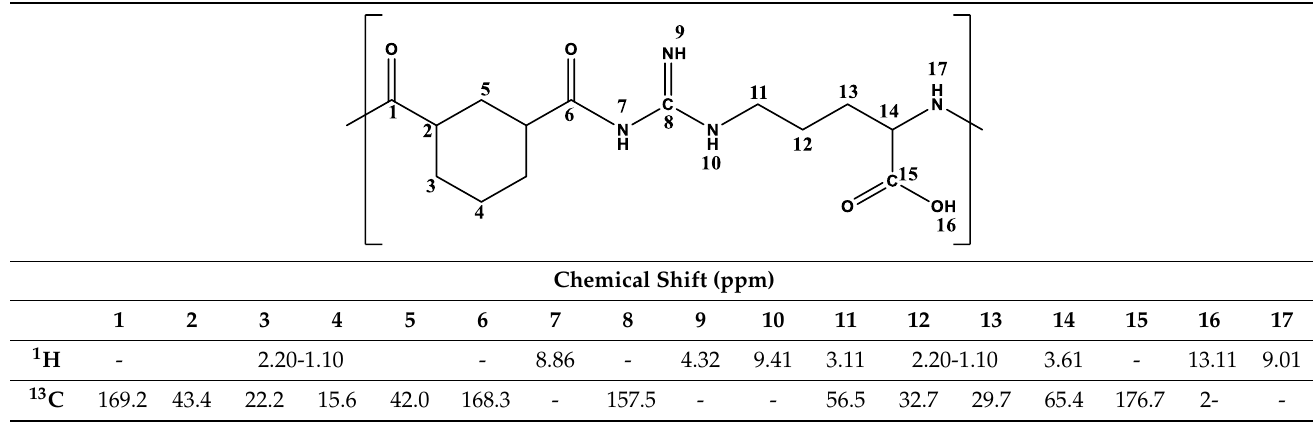
Figure 3. NMR spectra of Arg-PA: ( a ) 1 H NMR, ( b ) 13 C NMR . Table 3. 1 H NMR and 13 C NMR data of the synthesized Arg-PA.